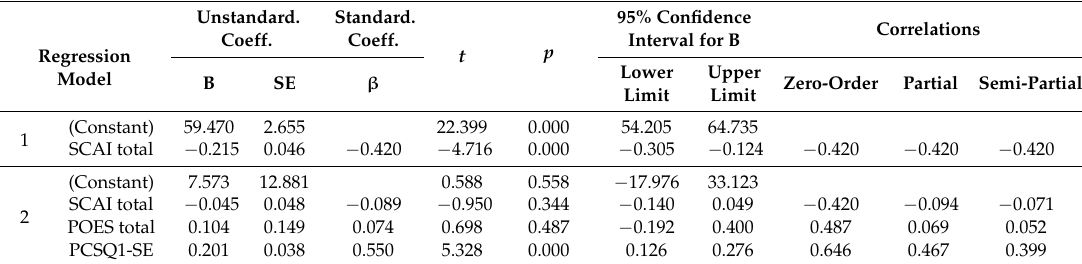
Table 3. Hierarchical regression coefficients (hypothesis 3 of the